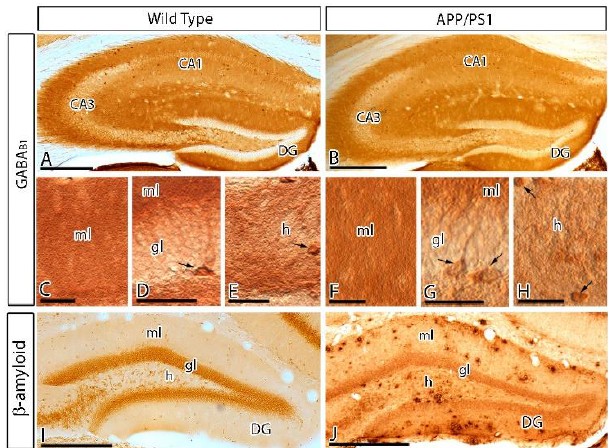
Figure 1. Regional and cellular distribution of the metabotropic γ-aminobutyric acid GABA B1 subunit (GABA B1 ) in wild type and APP/PS1 mice. ( A – H ) Immunoreactivity for GABA B1 in the dentate gyrus (DG) of wild type and APP/PS1 mice at 12 months of age using an immunohistochemical method at the light microscopic level. Immunoreactivity for GABA B1 was very similar both in the wild type and the APP/PS1 mice. Labelling for GABA B1 showed the highest intensity in molecular layer (ml) of the DG and weaker in the granule cell layer (gl). Immunoreactivity for GABA B1 was also detected in pyramidal basket cells (arrows) located in the granule cell layer and hilar neurons (arrows located in the hilus (h)), with similar distribution pattern and labelling intensity in wild type and APP/PS1 mice. ( I , J ) Immunoreactivity for β-amyloid in wild type and APP/PS1 mice, showing high accumulation of Aβ throughout all layers of the DG, and particularly high expression in the outer molecular layer. Abbreviations: CA1 region of the hippocampus (CA1); CA3 region of the hippocampus (CA3); dentate gyrus (DG); molecular layer (ml); granule cell layer (gc); hilus (h). Scale bars: A , B , I , J 200 µ m; C – H , 30 µ